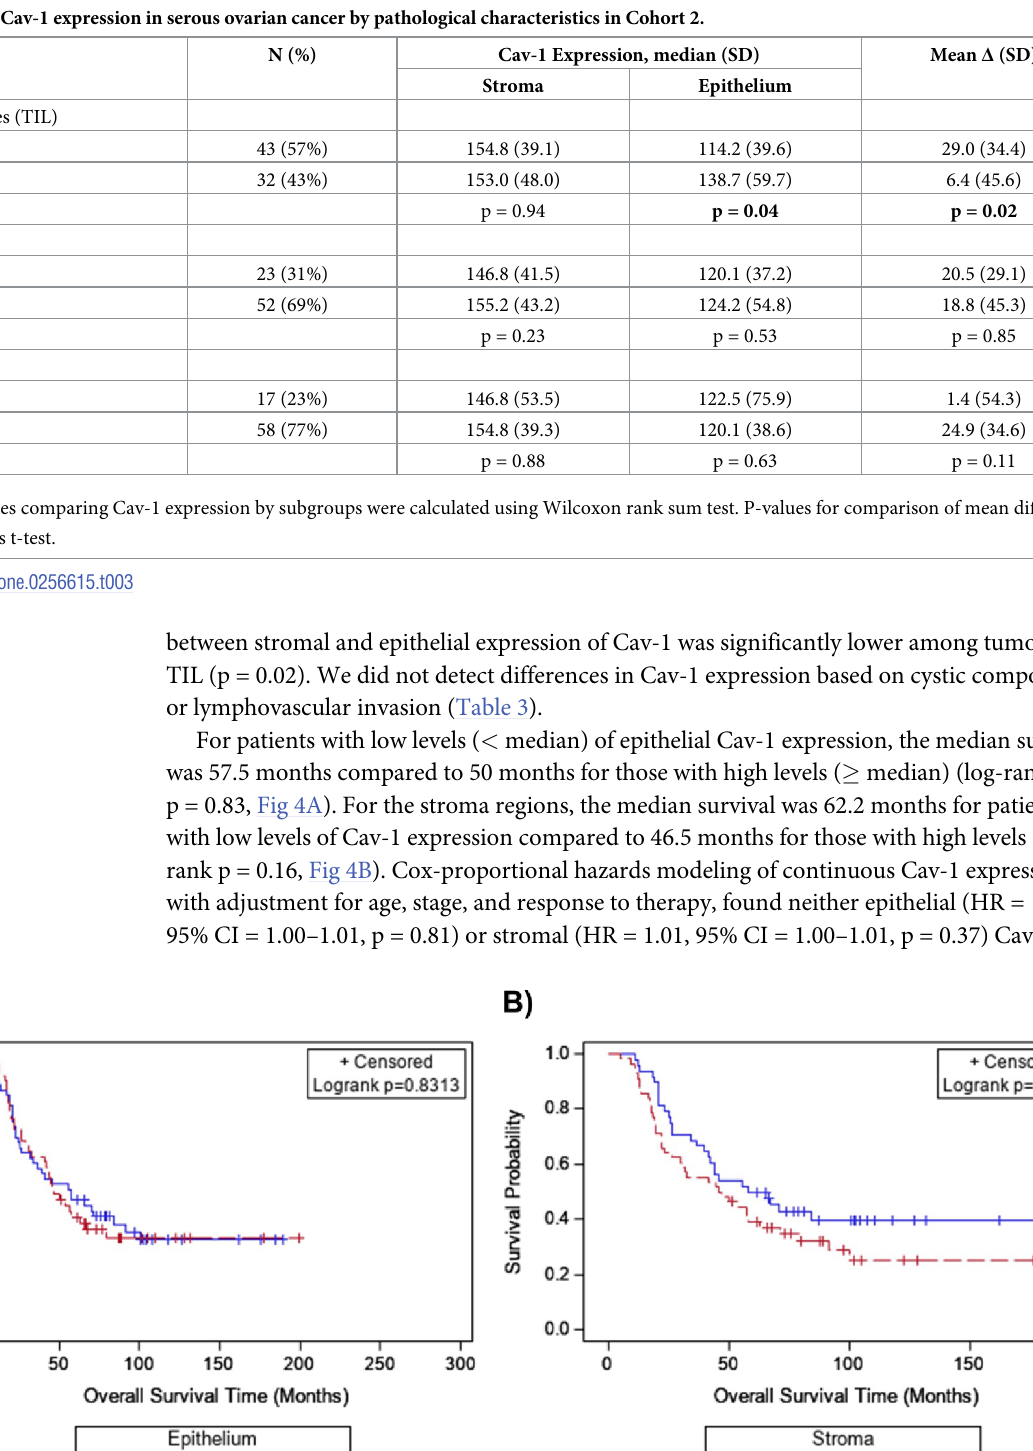
Table 3. Immunofluorescent Cav-1 expression in serous ovarian cancer by pathological characteristics in Cohort 2. Pathological Characteristics